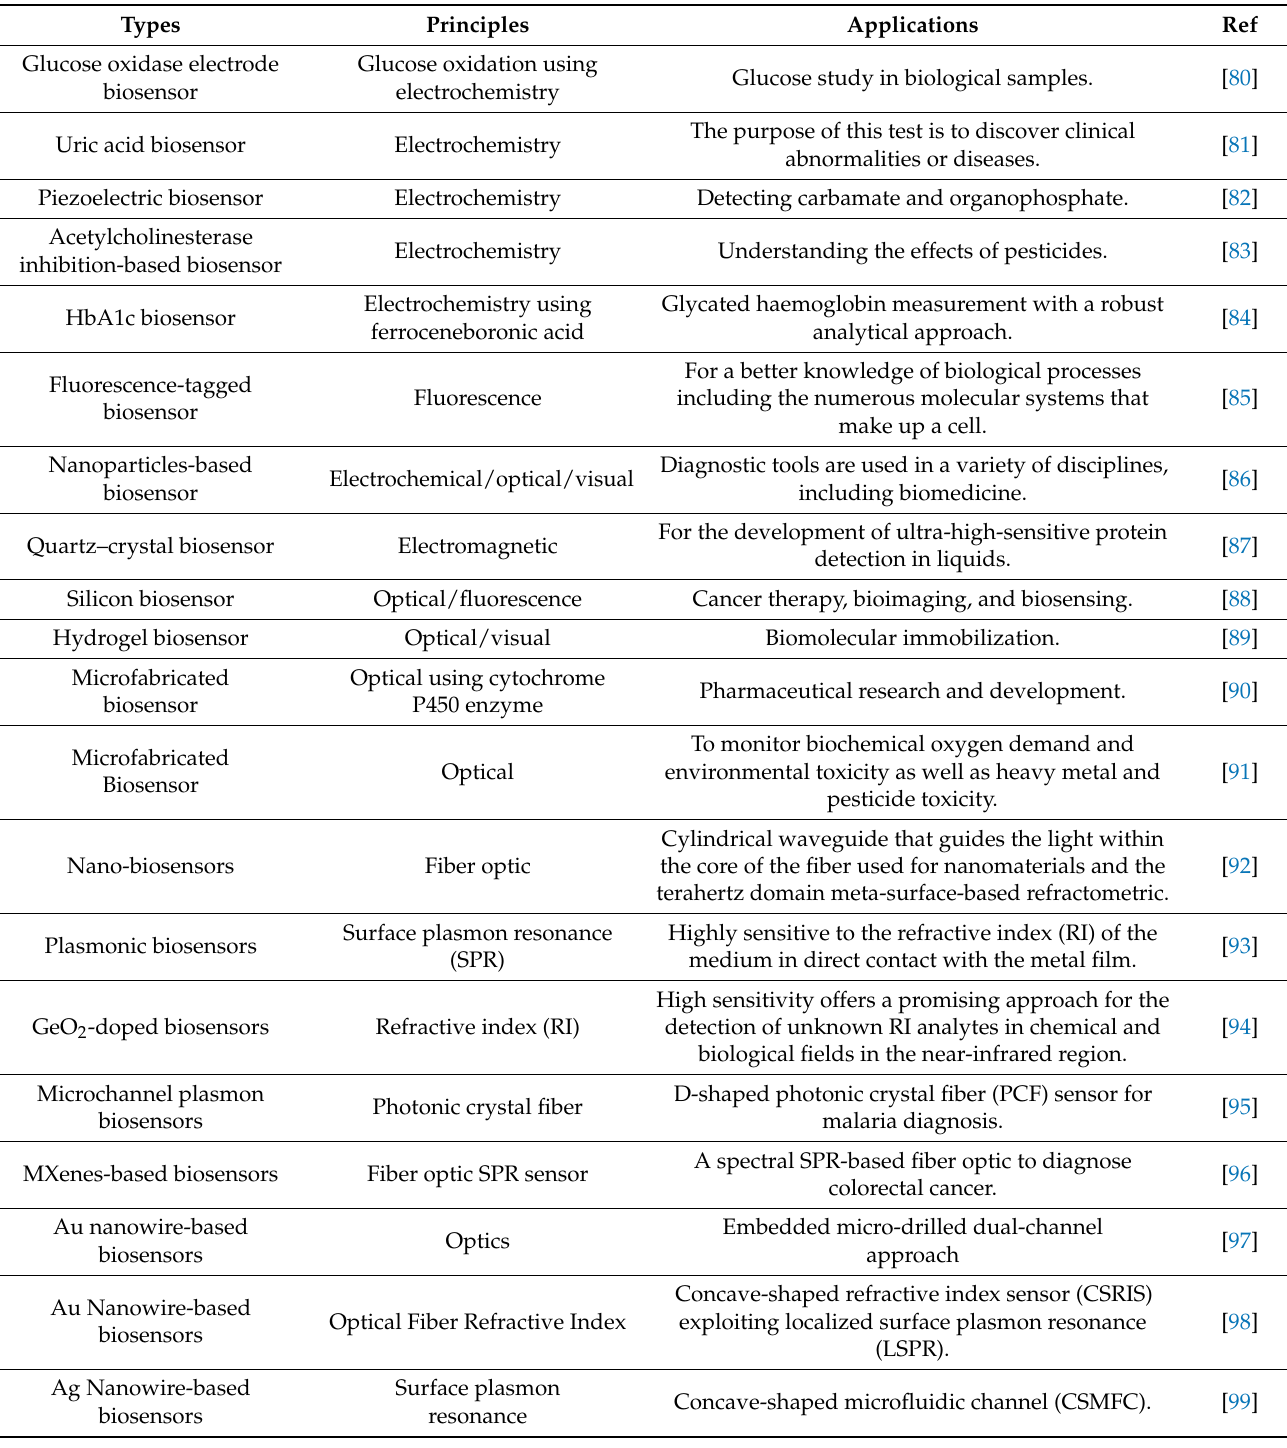
Table 4. Different types of biosensors with working principles and